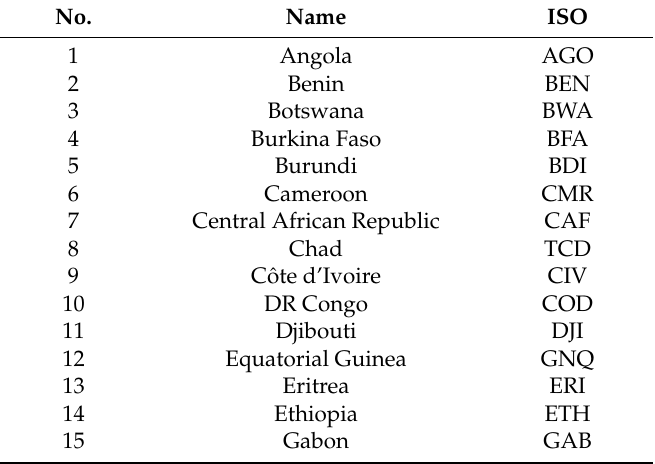
Figure A1. Sub-Saharan African countries selected for detailed geospatial analysis in this research. The numbers for the countries are identtified in Table A1. Table A1. Sub-Saharan African countries investigated in detailed geospatial analysis in this research.